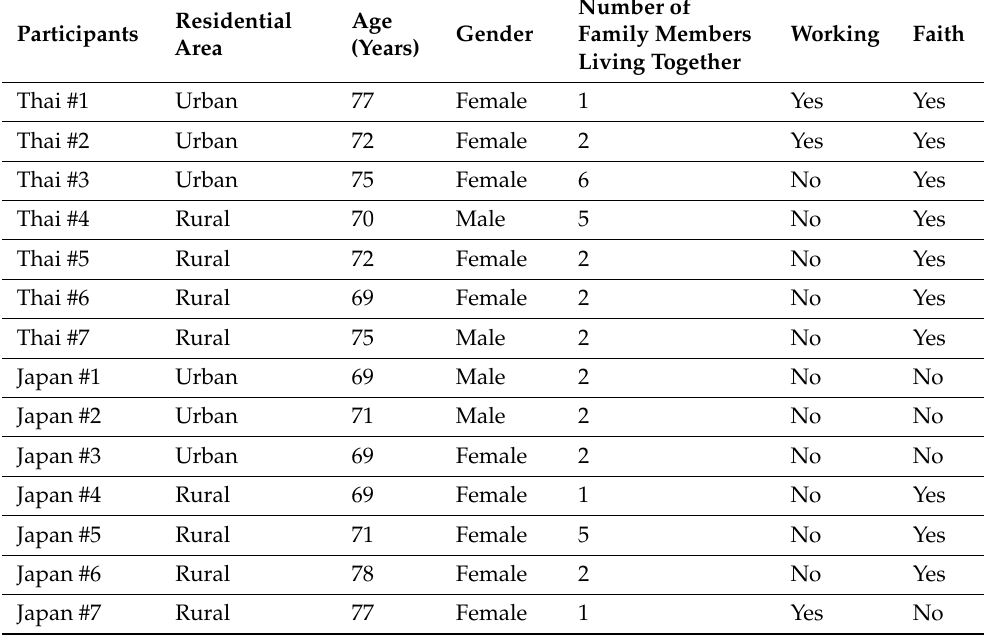
Table 1. Description of research